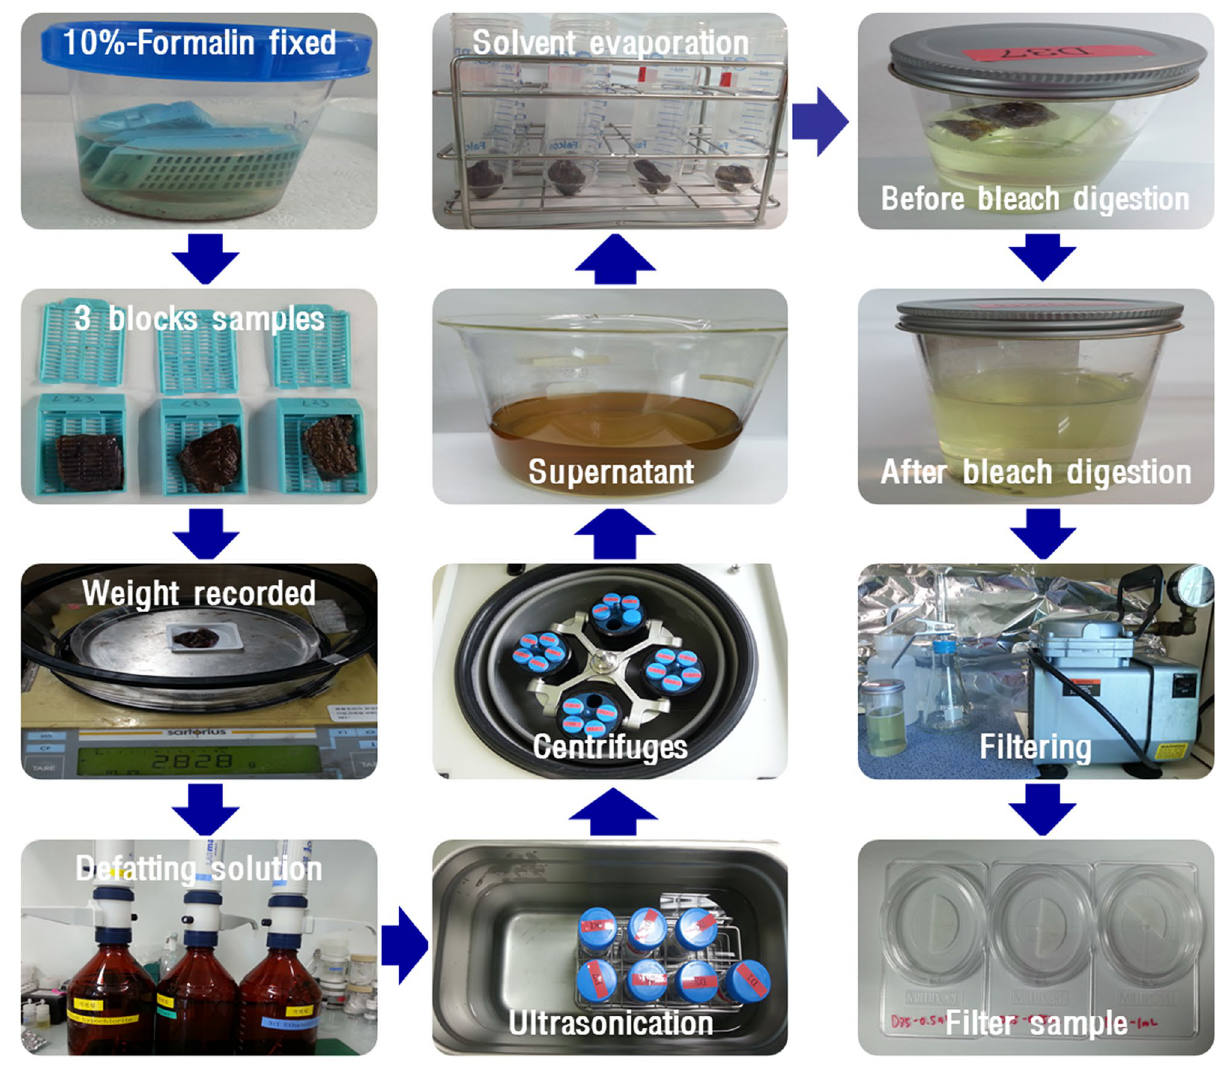
Figure 4. Pretreatment